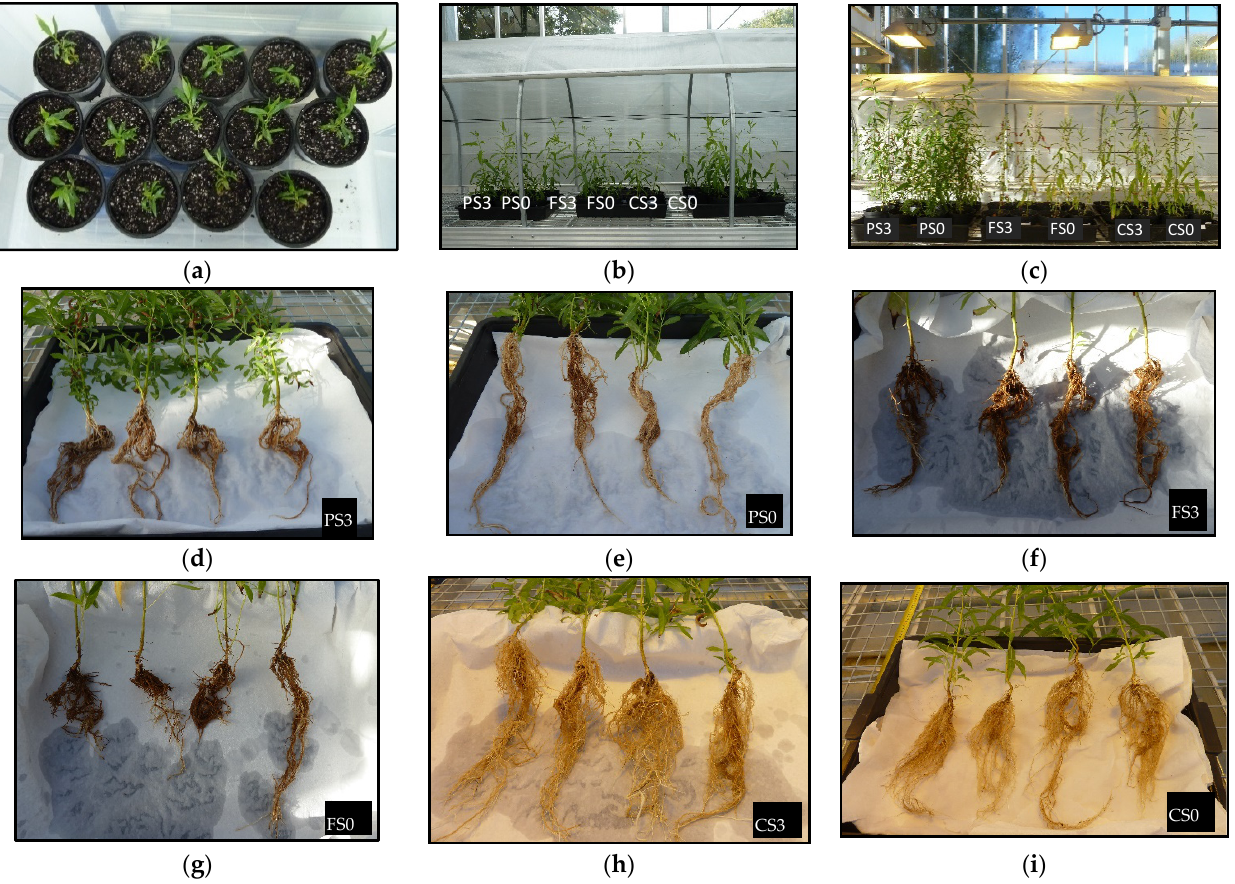
Figure 6. Acclimation of willow plantlets. ( a – c ) Plantlets at the time of transfer to phytotron ( a ), to the greenhouse ( b ) and 6 weeks afterwards ( c ). ( d – i ) Roots of plants grown in different soils upon completion of the experiment. PS0, PS3: plants grown in peat and micropropagated without sucrose (PS0) or with 3% sucrose (PS3); FS0, FS3: plants grown in a forest soil and micropropagated without sucrose (FS0) or with 3% sucrose (FS3); CS0, CS3: plants grown in a crop soil and micropropagated without sucrose (CS0) or with 3% sucrose (CS3).